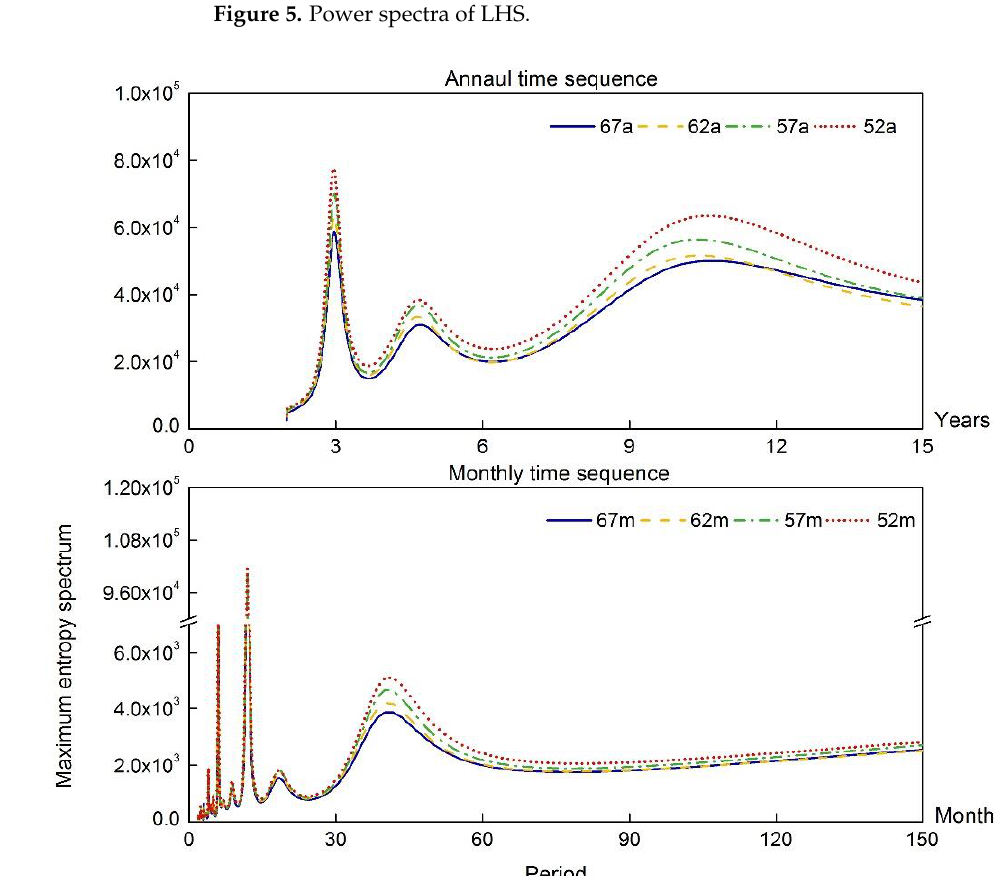
Figure 5. Power spectra of LHS.